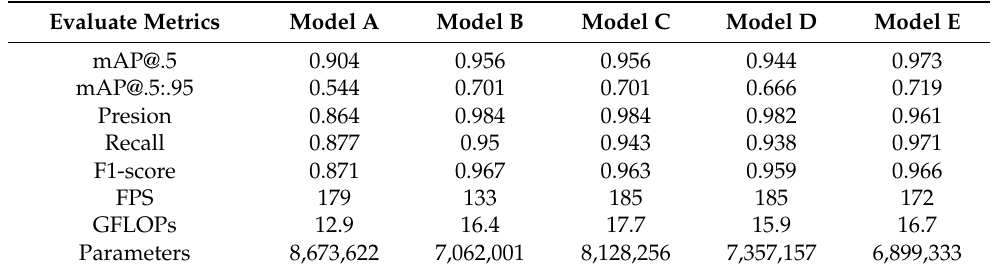
Figure 9. The PR curve and confusion matrix performance results of five types of transmission line disaster prevention safety detection models in the TLDPSD-2022 test set. ( a ) Comparison of PR curves; ( b ) confusion matrix of Model A; ( c ) confusion matrix of YOLOv5; ( d ) confusion matrix of Model C; ( e ) confusion matrix of Model D; ( f ) confusion matrix of Model E. Table 4. Evaluation results of different transmission line disaster prevention and safety detection models in the test set in the experiments of this paper.